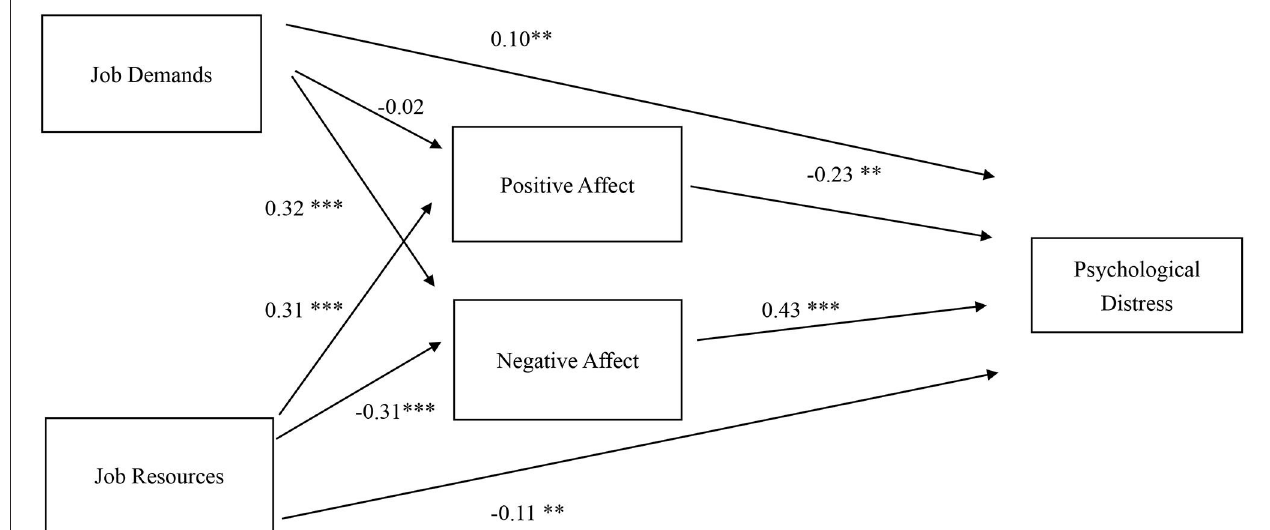
FIGURE 2 | Standardized estimates of JD-R, positive affect and negative affect, and psychological distress. ** p < 0.01; *** p <